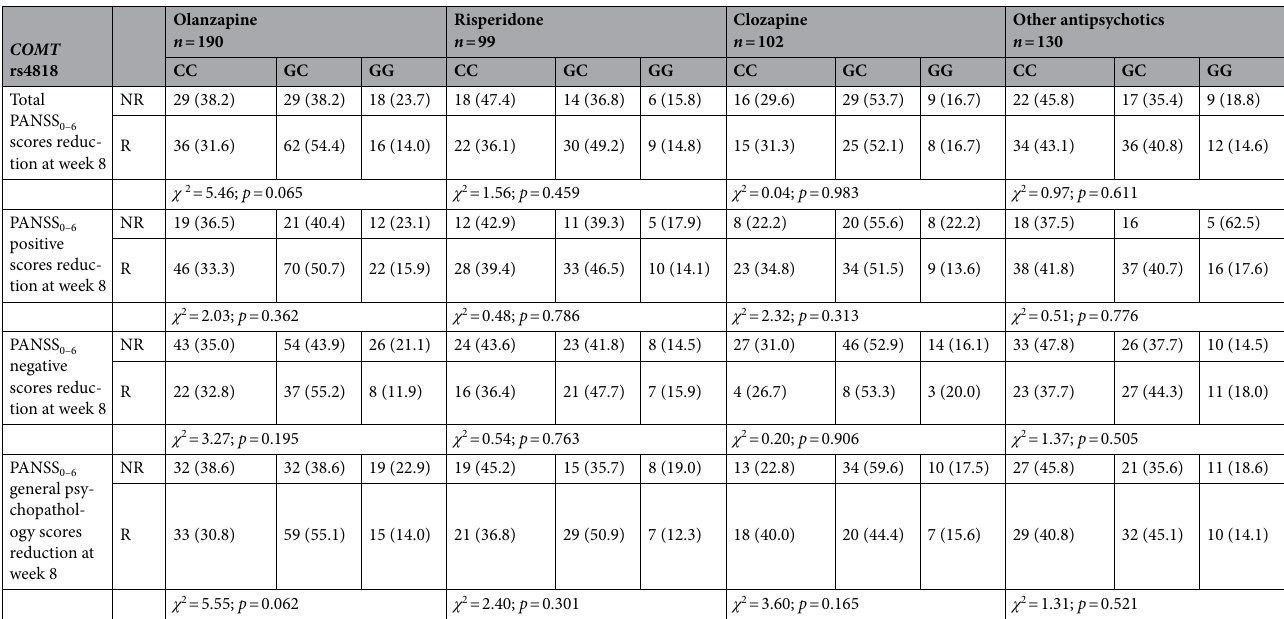
Table 4. The COMT rs4818 genotype count and frequencies in schizophrenia patients treated with olanzapine, risperidone, clozapine or other antipsychotics, subdivided into responders (R) and non-responders (NR) according to the 50% reduction in PANSS 0–6 total and subscale scores. Frequencies (%) are shown in parenthesis. n number of subjects, NR non-responders, PANSS positive and negative syndrome scale, R